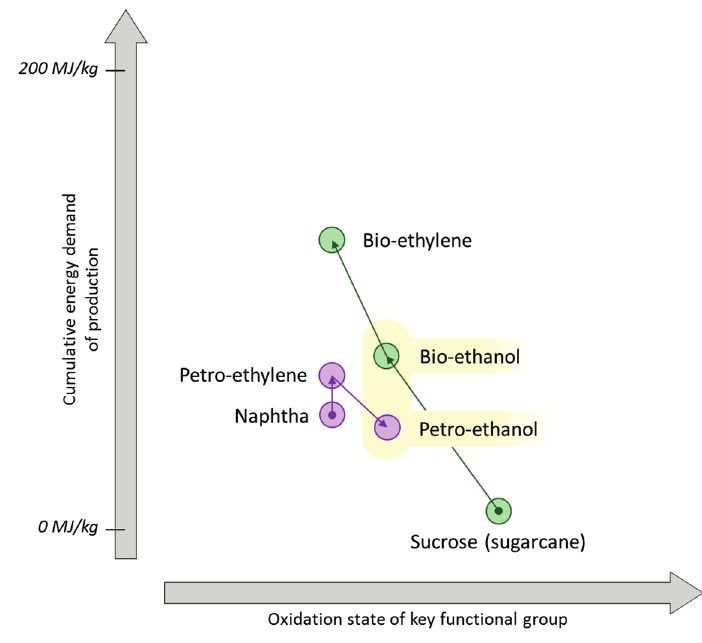
Figure 13. The energy comparison between the manufacture of petrochemical ethanol and bio-ethylene made from